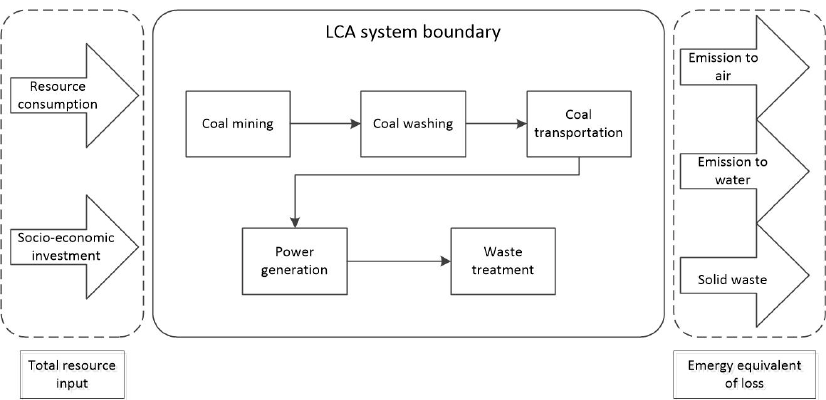
Figure1. Theemergy-baselifecycleassessment(Em-LCA)methodologyforcoal-firedpowergeneration. Figure 1. The emergy-base life cycle assessment (Em-LCA) methodology for coal-fired power generation.